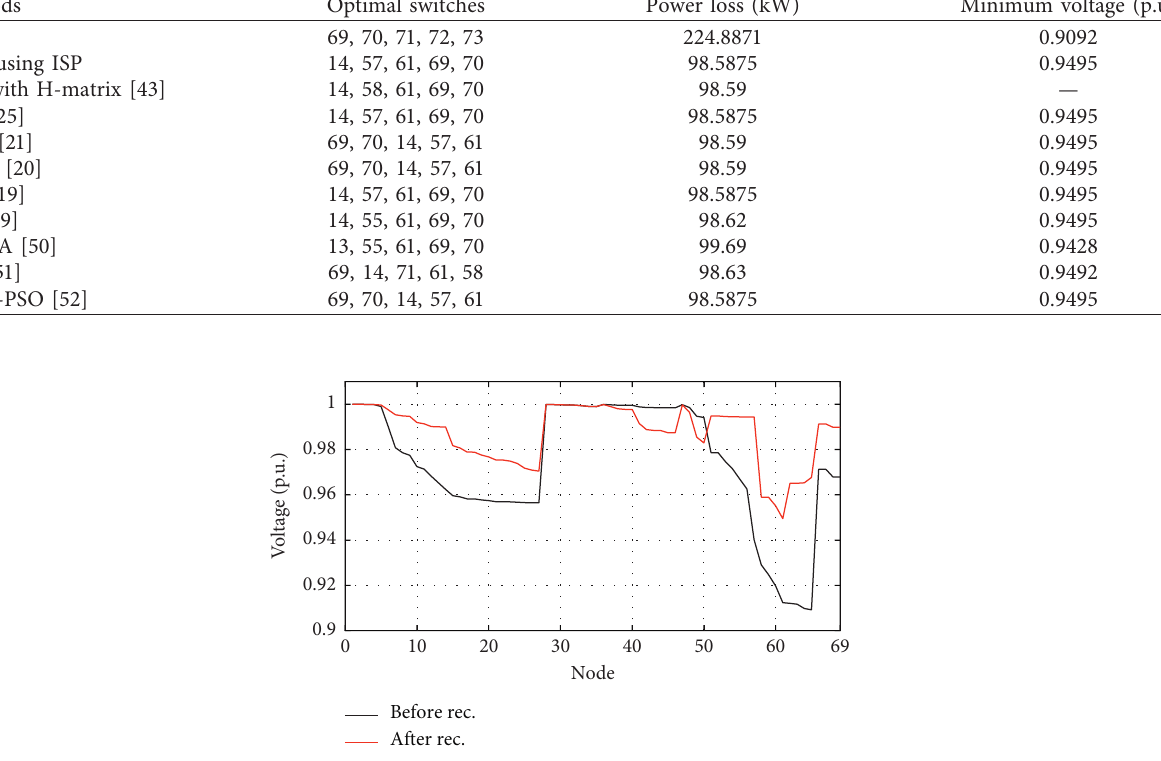
Figure 13: Voltage profile obtained for the 69-node